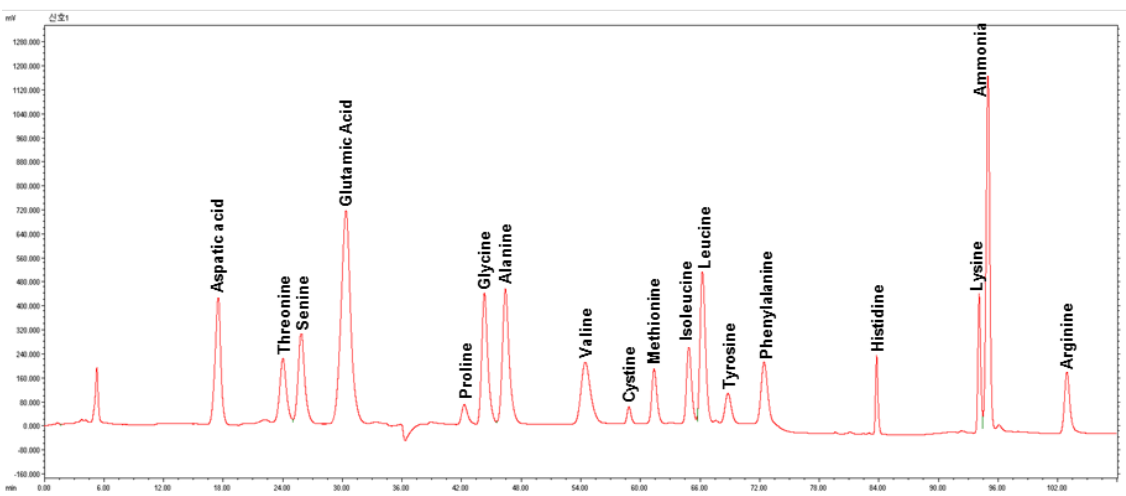
Figure 2. Representative chromatogram showing amino acid profile of teff seed flour (Addis-W). Y-axis is intensity (mAu); X-axis is retention time (min).